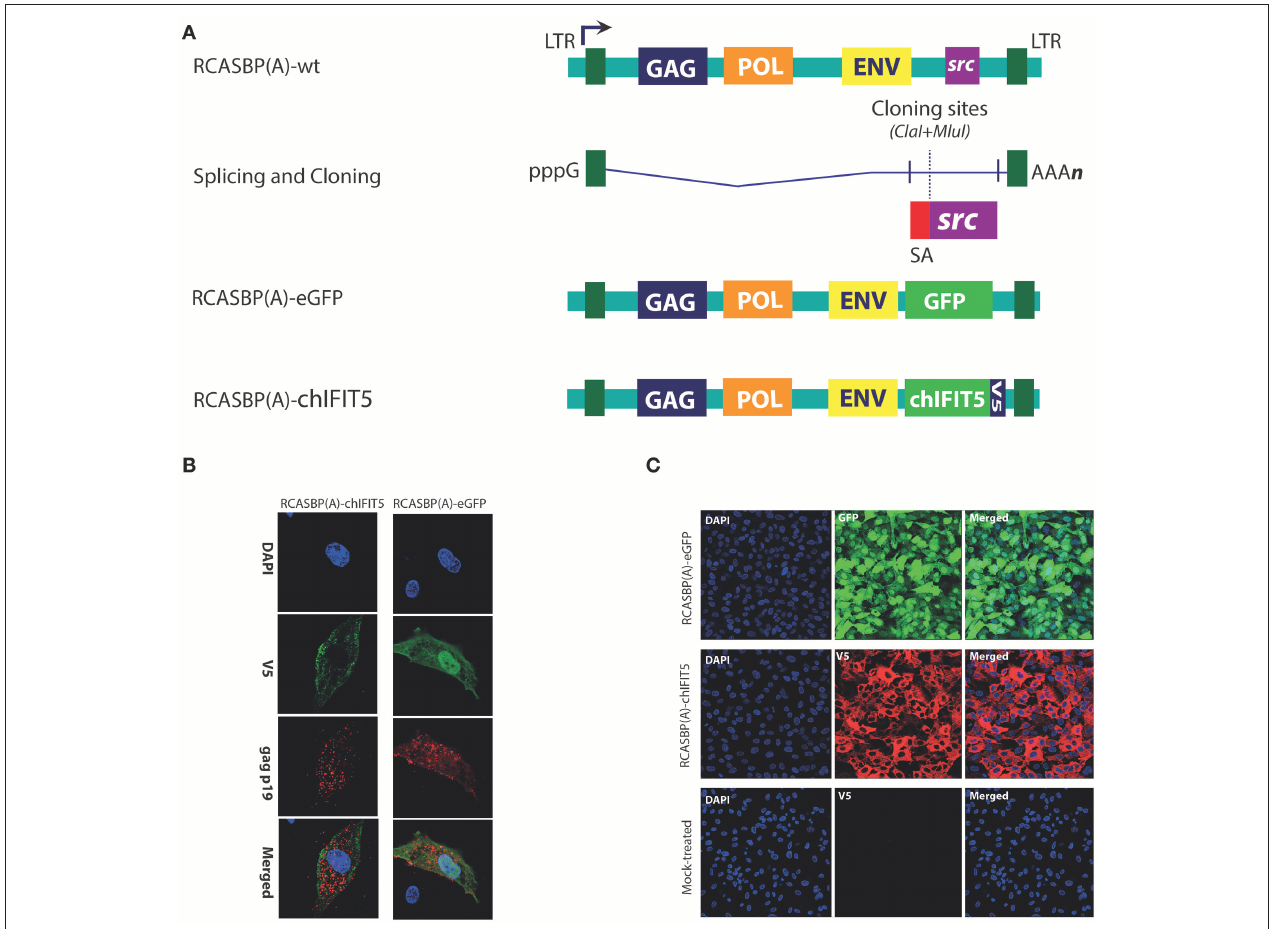
FIGURE 1 | Generation and rescue of recombinant retroviruses expressing marker gene (GFP), and chIFIT5. (A) A schema for the generation of recombinant RCAS viruses in which src gene was replaced with either GFP, or chIFIT5. (B) Retroviruses were rescued in DF-1 cells and stained for retroviral structural gag protein and V5-taged fused to the chIFIT5, indicating the specific replication-competency of these retroviruses. (C) Immunofluorescence staining of the transgene in chicken fibroblasts expanded from individual clones expressing RCAS-mediated GFP and IFIT5 indicating stable and substantial expression of these proteins.